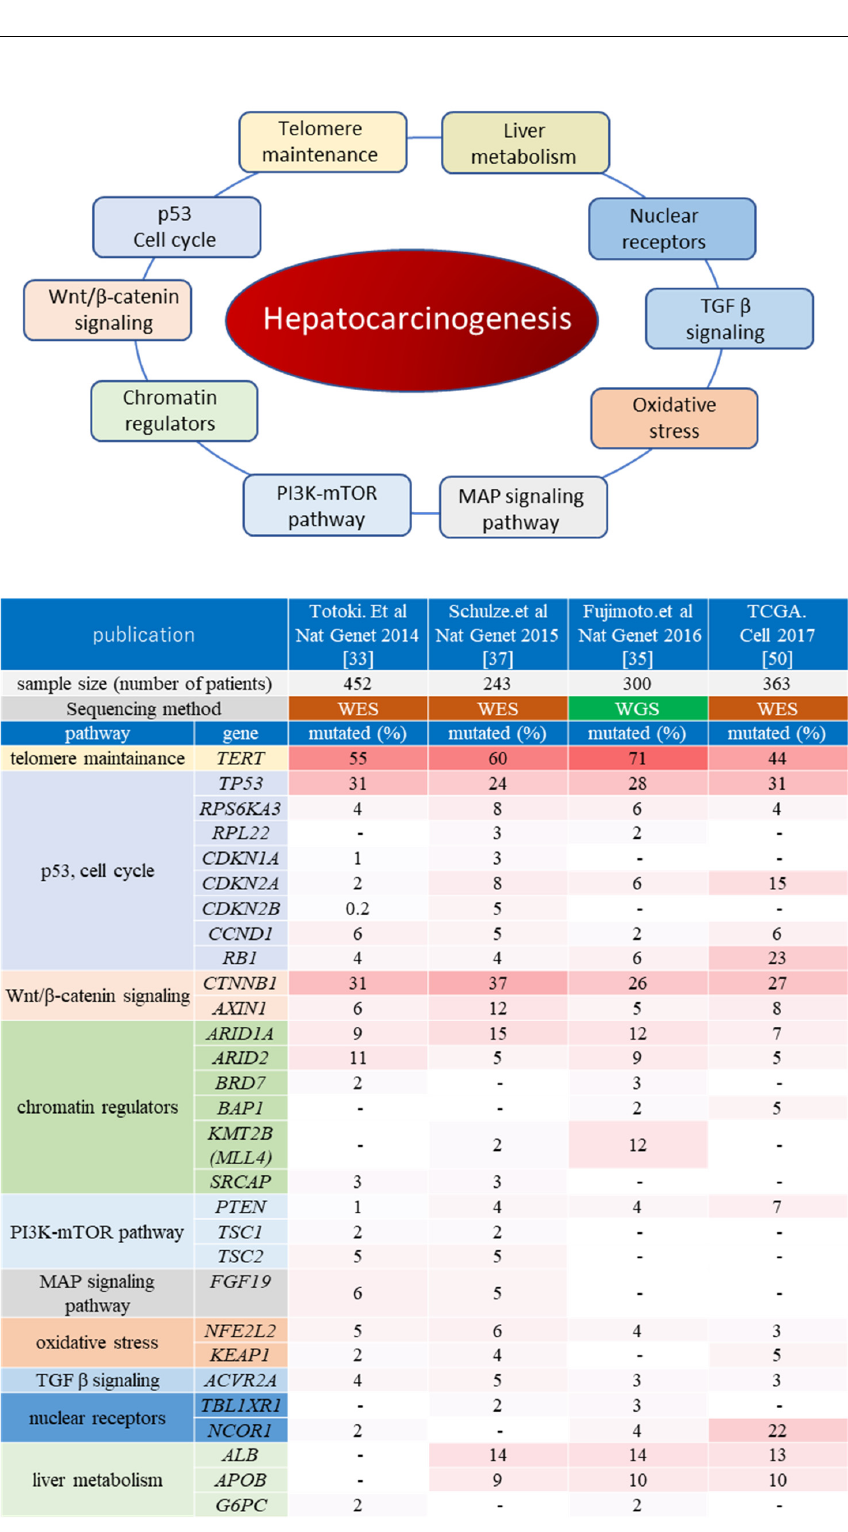
Figure 1. Oncogenic pathways associated with hepatocarcinogenesis. The upper panel shows the major oncogenic pathways elucidated via comprehensive genome analysis projects. The lower heatmap indicates the genes which have been reported as putative liver cancer driver genes in at least two publications of ICGC/TCGA projects. The top row shows each publication, and the second row shows the number of liver cancer samples analyzed. The major pathways and representative cancer-related genes for each pathway are listed on the left. The mutation frequency of each gene (percentage of the cases with mutated genes among all cases analyzed in each cohort) is shown as a heatmap. WES: whole-exome sequencing; WGS: whole-genome